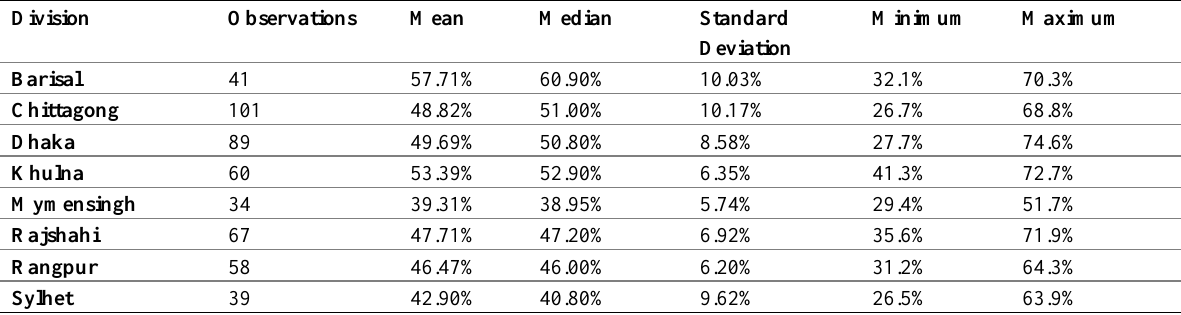
Table 1: Summary of Descriptive Statistics (Literacy Rate)